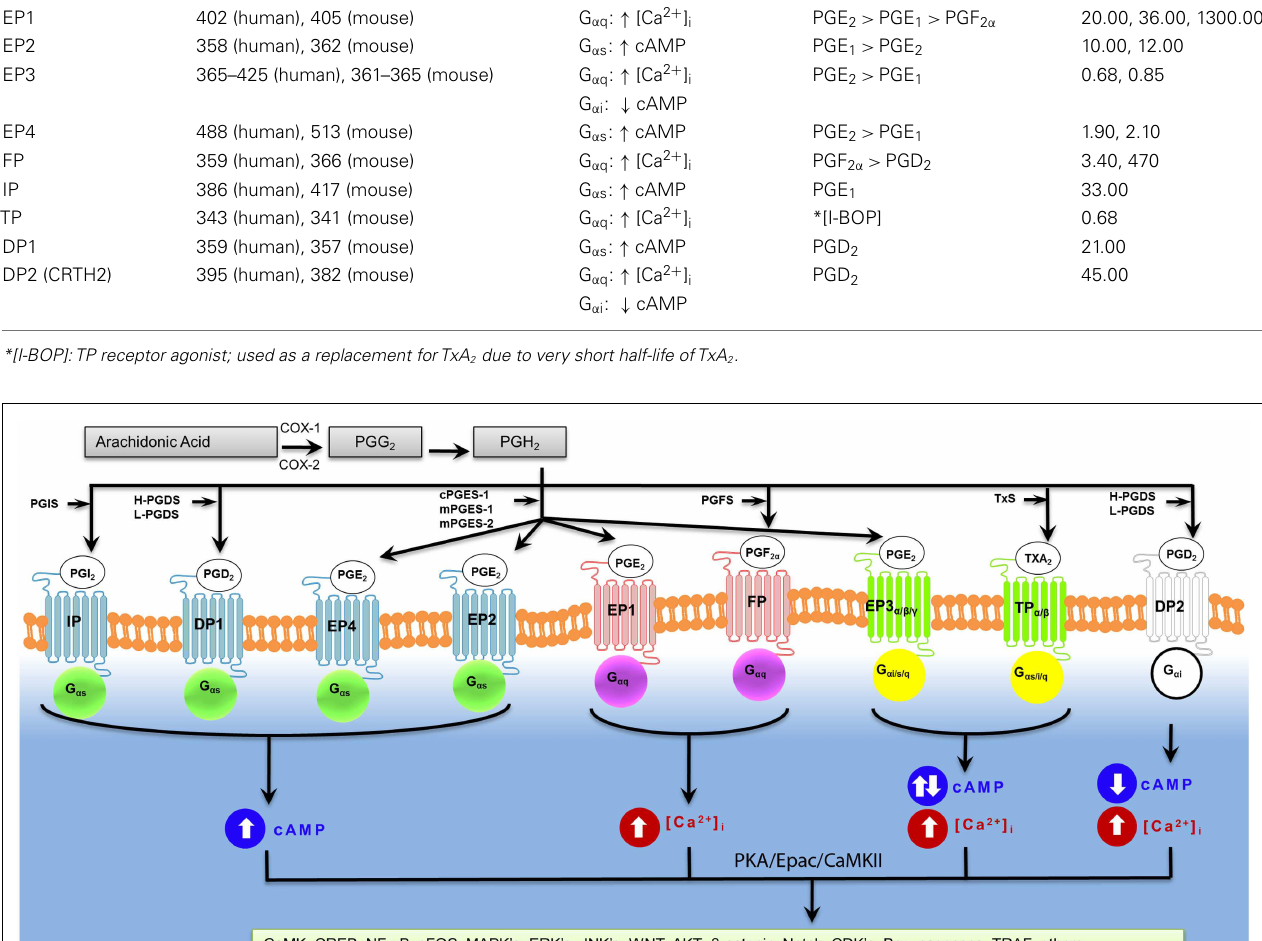
Table 2 | Structural, signal transduction, and agonist binding properties of mouse prostaglandin receptors. Receptor Amino acids: human vs. mouse